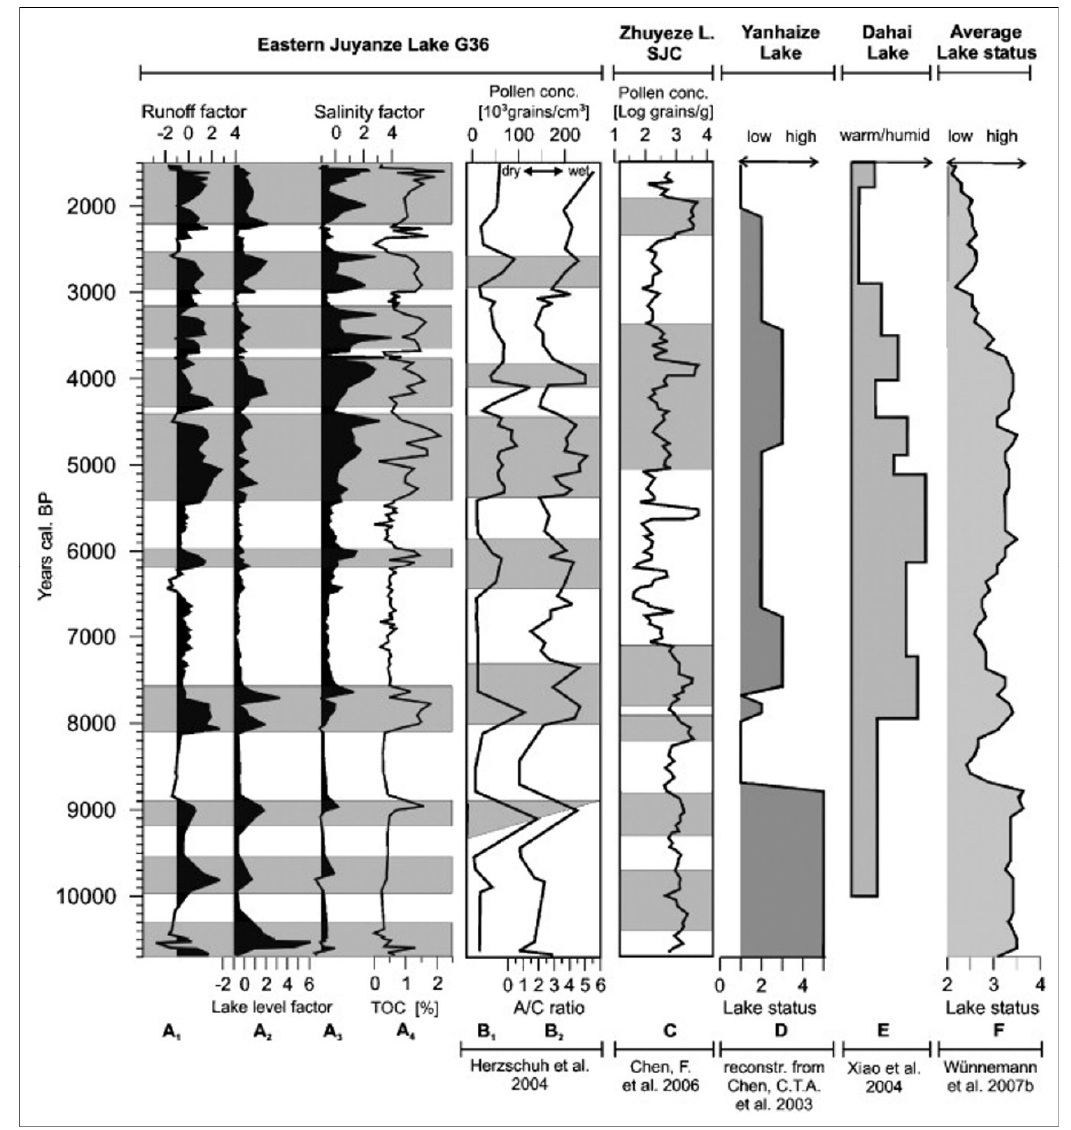
Figure 5. Comparison of climatic records in arid areas of Northwestern China from the northern Alashan Plateau to the northern margin of the Tibetan Plateau in a west–east transect (modified from [32,46–50]). TOC, total organic carbon.